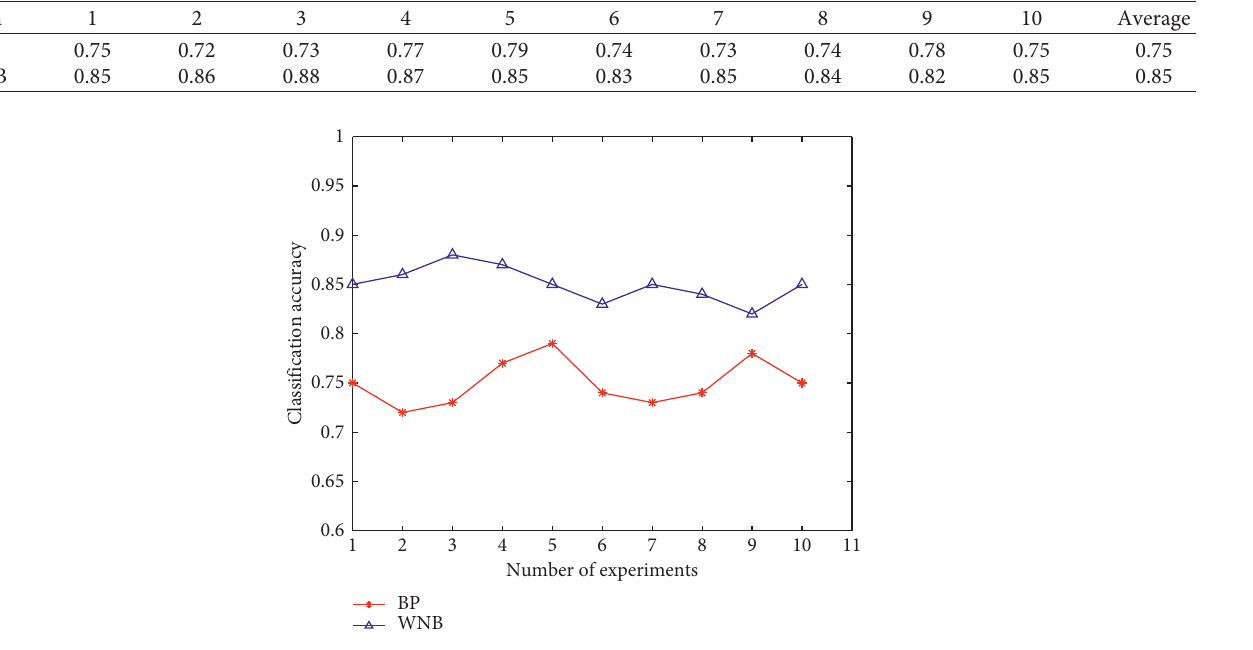
Figure 5: Comparison of classification accuracy between BP and WNB algorithm. Table 4: The calculation results of certain test data.